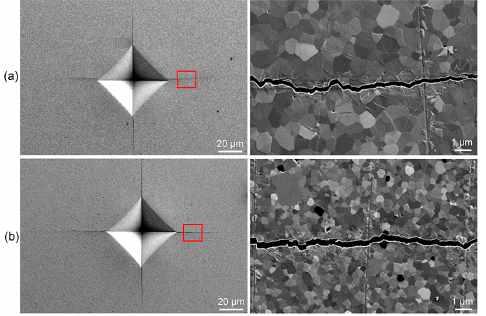
Figure 6. SEM images of the fractured surfaces of the SM ( a ) and SLA ( b ) Y-TZP ceramics after the three-point flexural strength test (magnification = 10,000×; scale bar = 1 μ m).